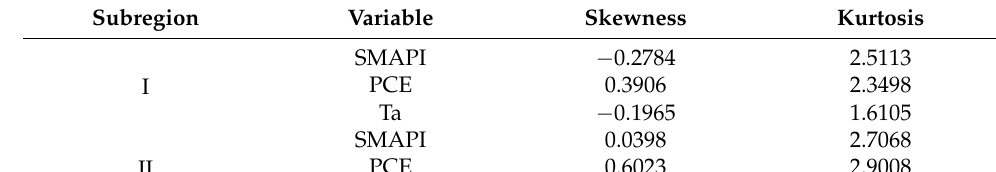
Table 2. Skewness and kurtosis of SMAPI, PCE, and Ta.